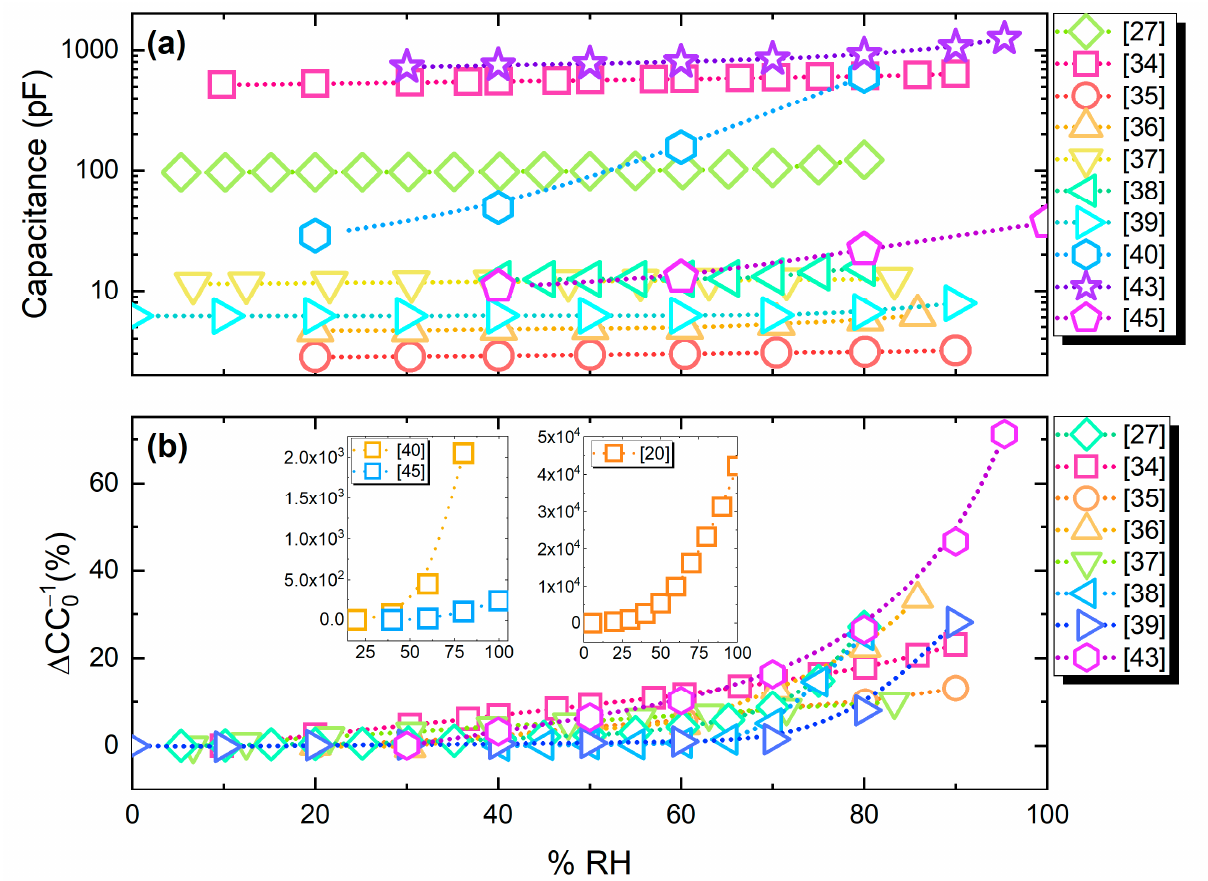
Figure 13. ( a ) Absolute response of capacitive humidity sensors; ( b ) relative capacitance change